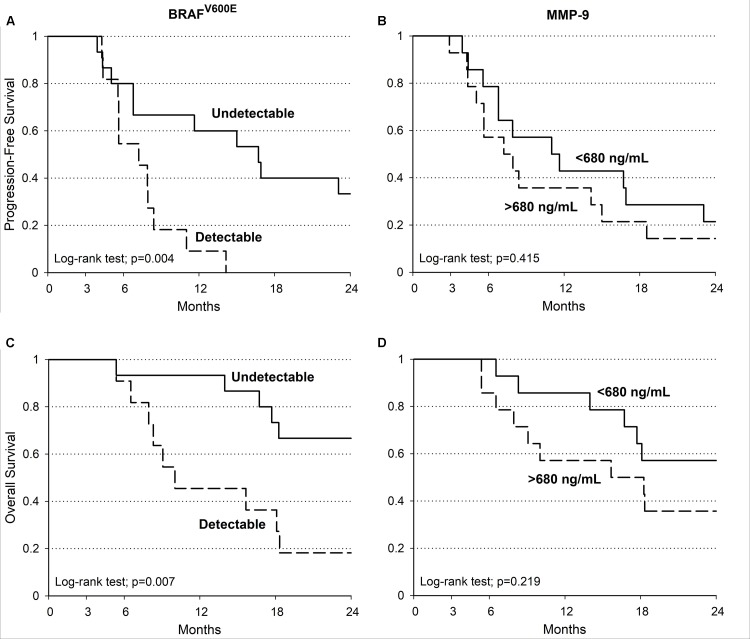
Melanoma patients PFS and OS. Kaplan–Meier estimate of PFS and OS in patients with detectable (dotted line) and undetectable (continuous line) BRAFV600E (PFS log-tank test: p = 0.004; OS log-tank test: p = 0.007) (A,C). PFS and OS evaluations in patients with MMP-9 serum concentration at baseline (continuous line: < 680 ng/mL; dotted line: ≥ 680 ng/mL; PFS log-tank test: p = 0.415; OS log-tank test: p = 0.219) (B,D).